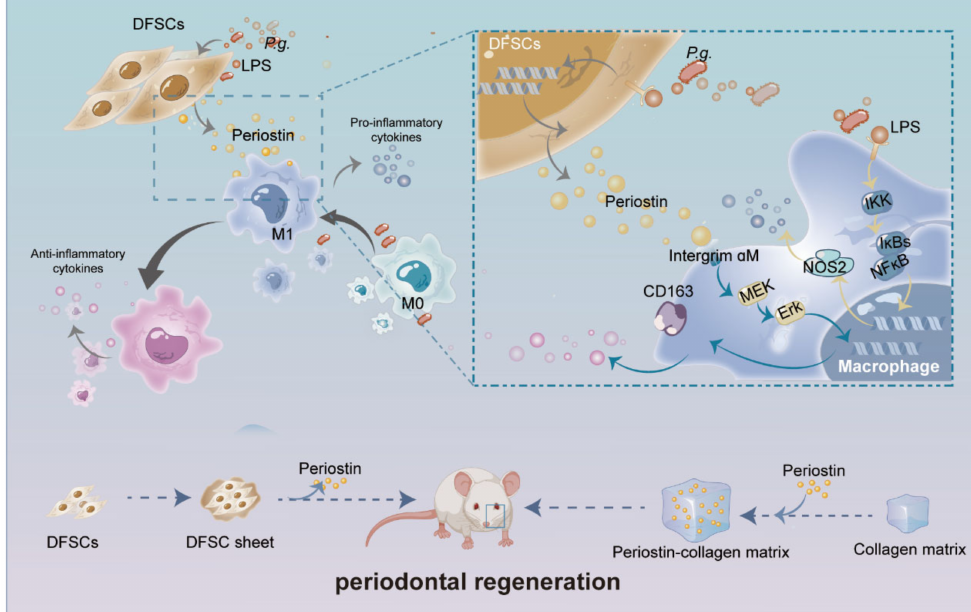
Figure 8. Schematic diagram of the role and mechanism of periostin in the promotion of periodontal regeneration by DFSCs. Periostin is actively involved in DFSC-mediated periodontal regeneration through regulating macrophages via integrin α M/p-Erk/Erk signaling and is a promising molecular agent to promote periodontal